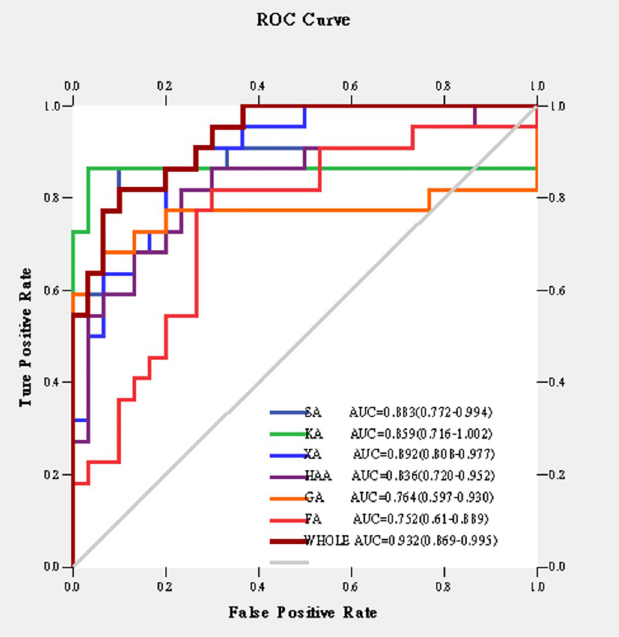
Fig 9. Sensitivity comparison. SA: Salicyluric acid; KA: Kynurenic acid; XA: Xanthurenic acid; HAA: 3-Hydroxyanthranilic acid; GA: Gentisic acid; FA: Ferulic acid; WHOLE: The prediction model, Comp1 = XA � 0.033 +3-HAA � 0.024+ GA � 0.009+ SUA � 0.005+ FA � 0.003+ KA � 0.004.